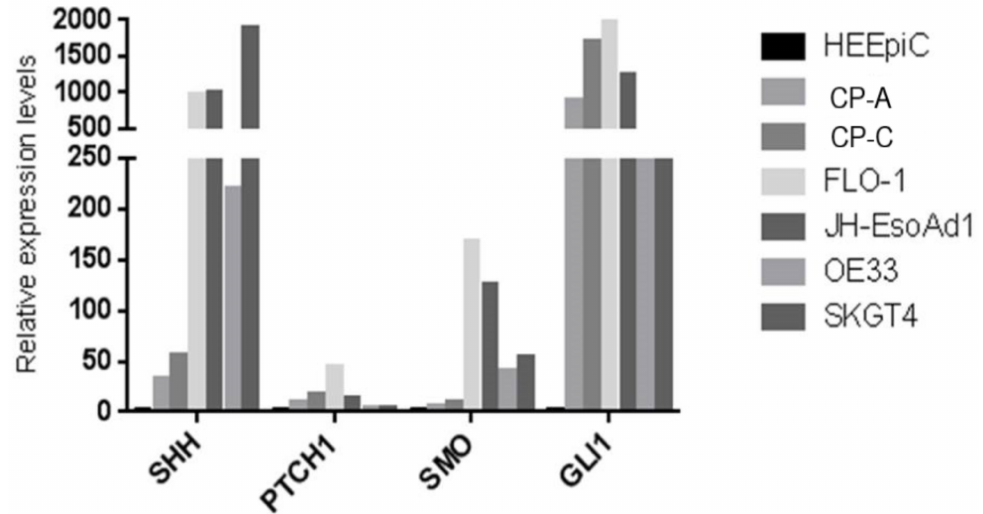
Figure 14. Upregulation of key Sonic Hedgehog ( SHH ) pathway genes SHH, PTCH1, SMO , and GLI1 in both BE and EAC cells. qRT-PCR of BE and EAC cell lines vs. primary NE (HEEpiC) cells revealed that RNA expression levels of the key SHH pathway genes SHH, PTCH1, SMO, and GLI1 were upregulated in both BE (CP-C and CP-A) cell lines and in all four EAC (FLO-1, JH-EsoAd1, OE33, and SKGT4) cell lines